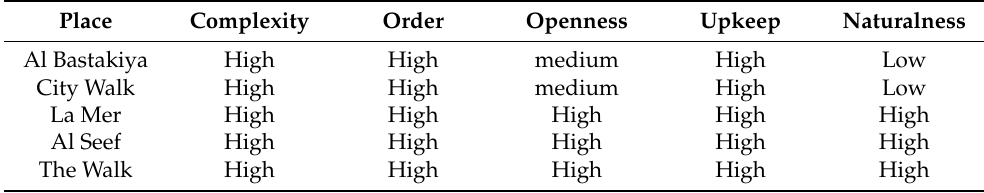
Table 2. Comparison between built environments’ physical attributes. Place Complexity Order Openness Upkeep Naturalness Al Bastakiya High High medium High Low City Walk High High medium High Low La Mer High High High High High Al Seef High High High High High The Walk High High High High